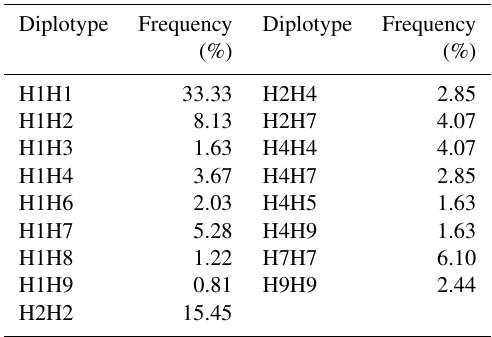
Table 5. Diplotypes and frequencies of the four mutations in the AMH exon